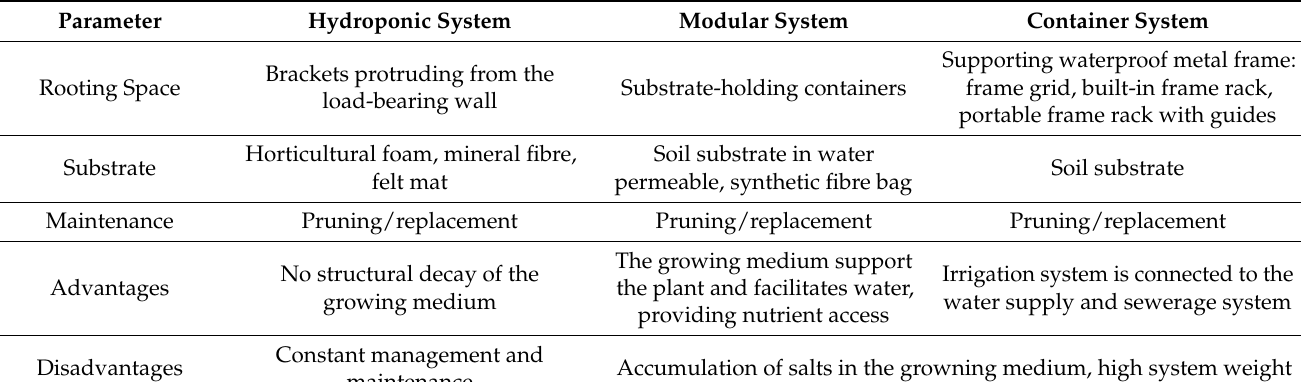
Table 1. The comparative characteristics of different types of green wall systems.